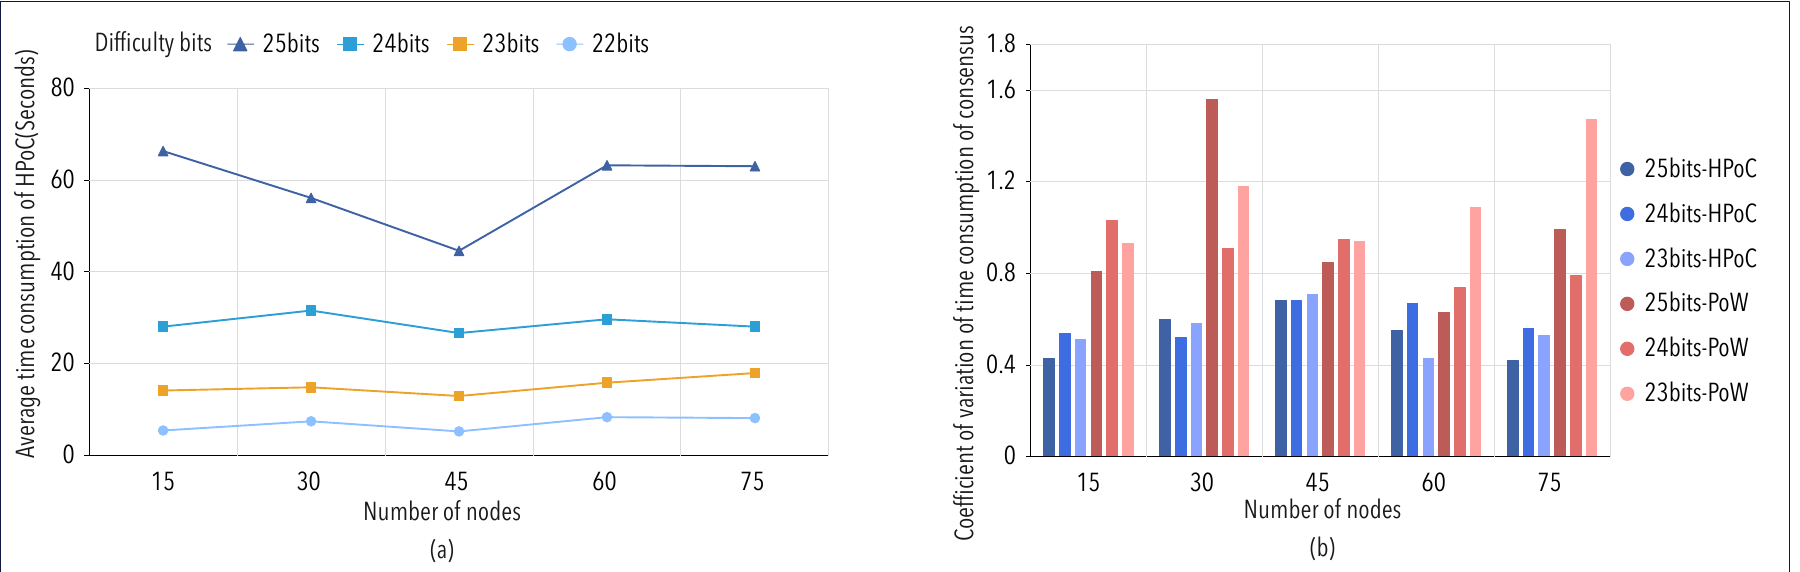
Figure 8. Simulation results: ( a ) average time consumption of HPoC with four difficulty bits; ( b ) comparison of coefficient of variation of time consumption between HPoC and PoW with three difficulty